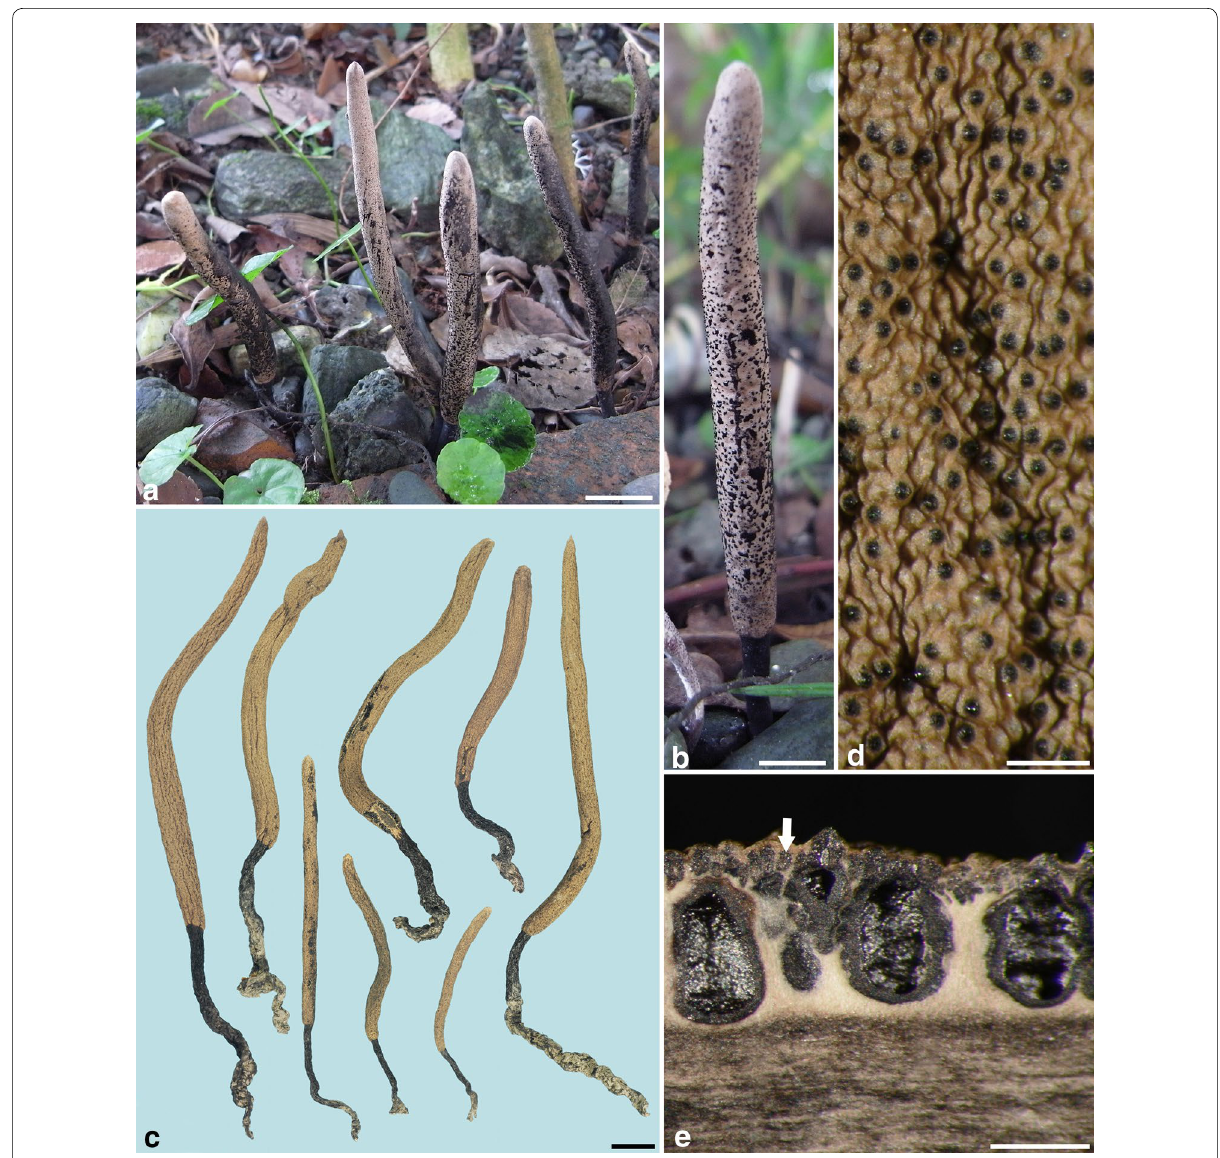
Fig. 5 Xylaria subescharoidea (from the holotype). a , b Stromata in natural habit showing black exudated ascospore masses deposited on the surface. c Dried stromata. d Stromatal surface tuberculate at and between perithecial mounds. e Vertical section of perithecia; the arrow points towards one of the black ellipsoidal granules between ostioles. Bars in a , c